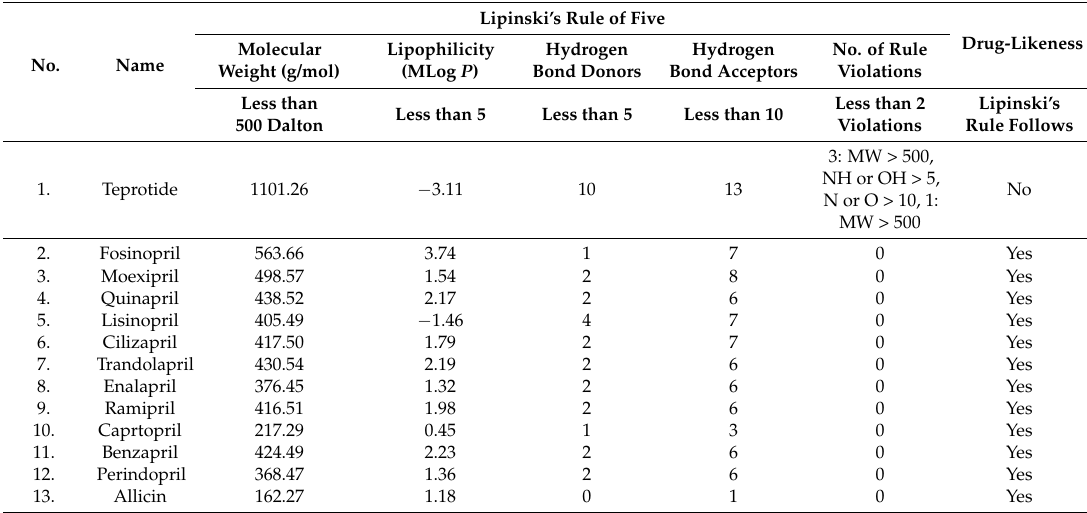
Table 6. Lipinski’s rule of five for ADME analysis of our inhibitors (ligands)